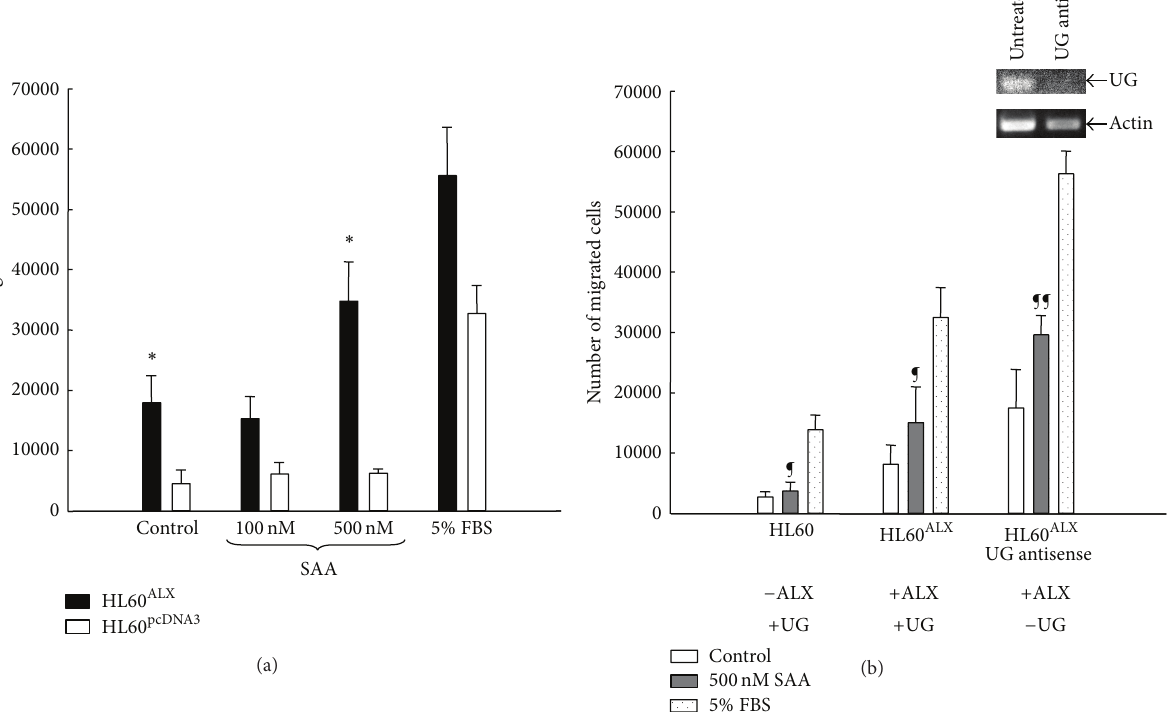
Figure 4: SAA-stimulated migration of HL-60 is mediated by ALX while being inhibited by UG. (a) Migration of HL 60 ALX and HL60 into the lower chamber when SAA at two different concentrations (100 and 500 nM) or 5% FBS (positive control) are added. (b) Migration of HL60, HL 60 ALX , and UG-antisense treated HL60 cells when SAA (500nM) or 5% FBS were added. Results are the mean ± SD of four separate experiments with triplicate